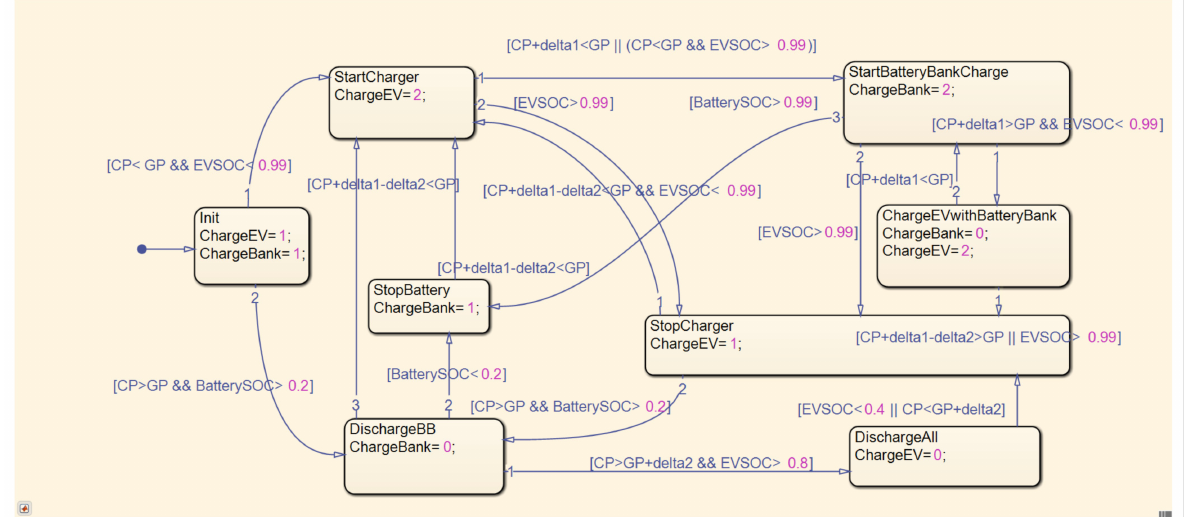
Figure 7. General Control